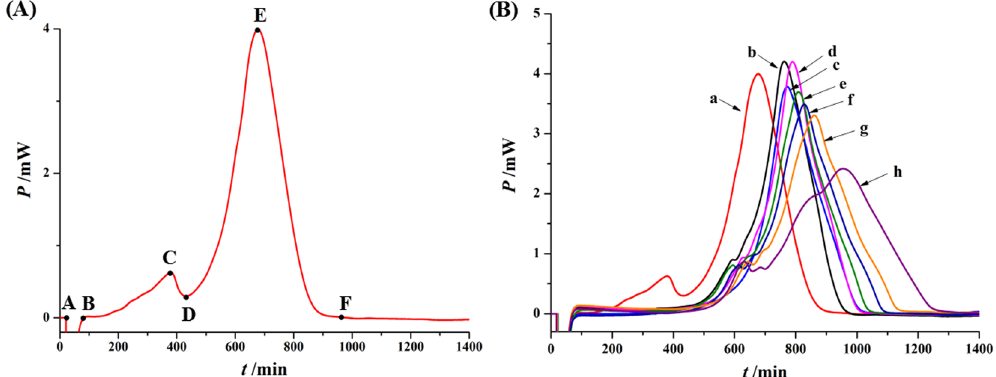
Figure 3. The power-time curves of P . aeruginosa growth at 37 °C ( A ) without the samples, and ( B ) affected with different concentrations of S . miltiorrhizae extracts. a–h Represent the concentrations of 0, 50, 100, 250, 500, 750, 1000 and 2000 μ g/mL of S . miltiorrhizae